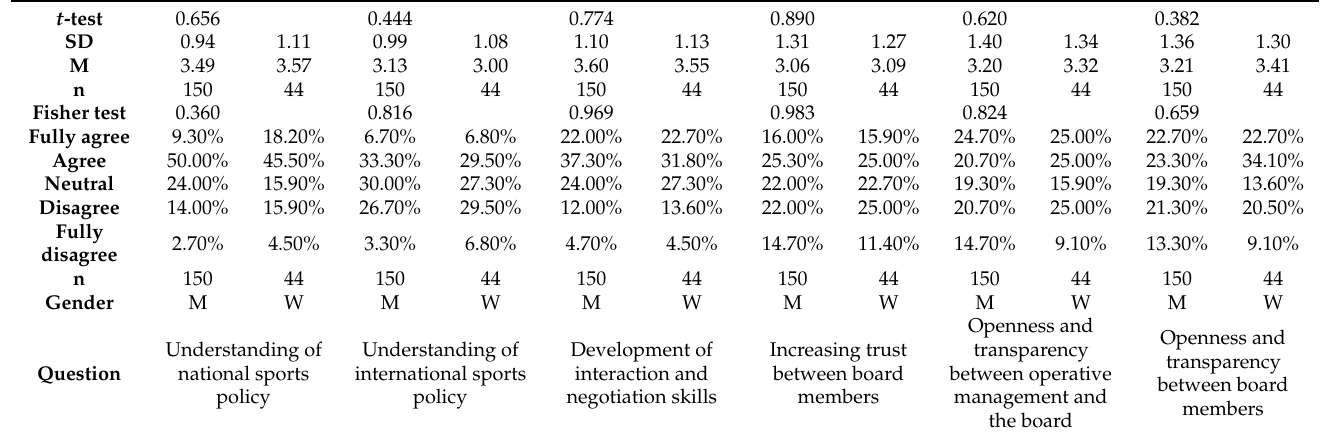
Table 2. Skills and capabilities needed in future in